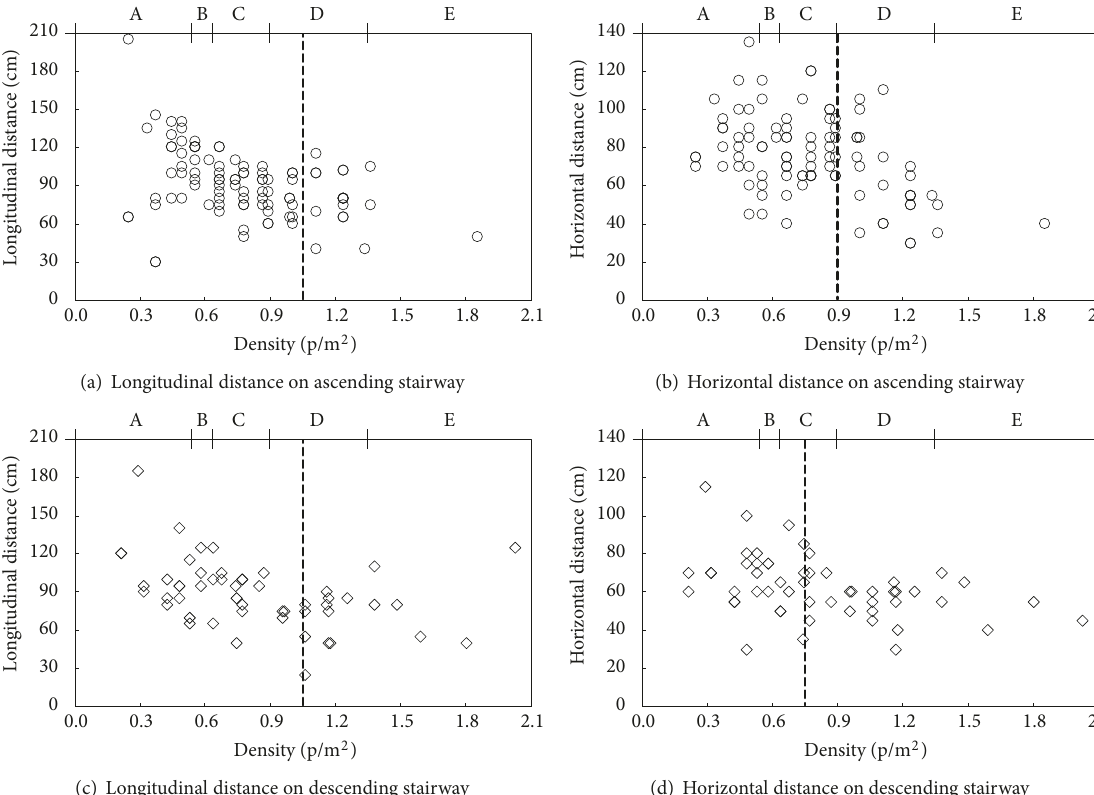
Figure 10: Microscopic distance indicators of pedestrian overtaking behavior.